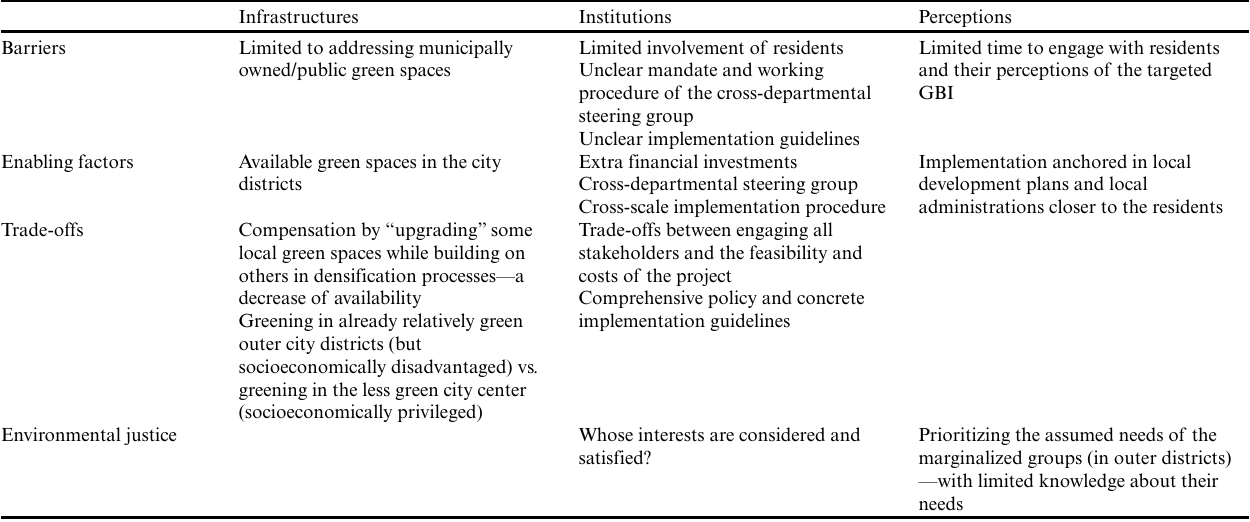
Table 9. ENABLE filters mediating the flow of benefits from GBI to potential beneficiaries translated into an analytical framework for the assessment of GBI-related initiatives—in the case of the Greener Stockholm